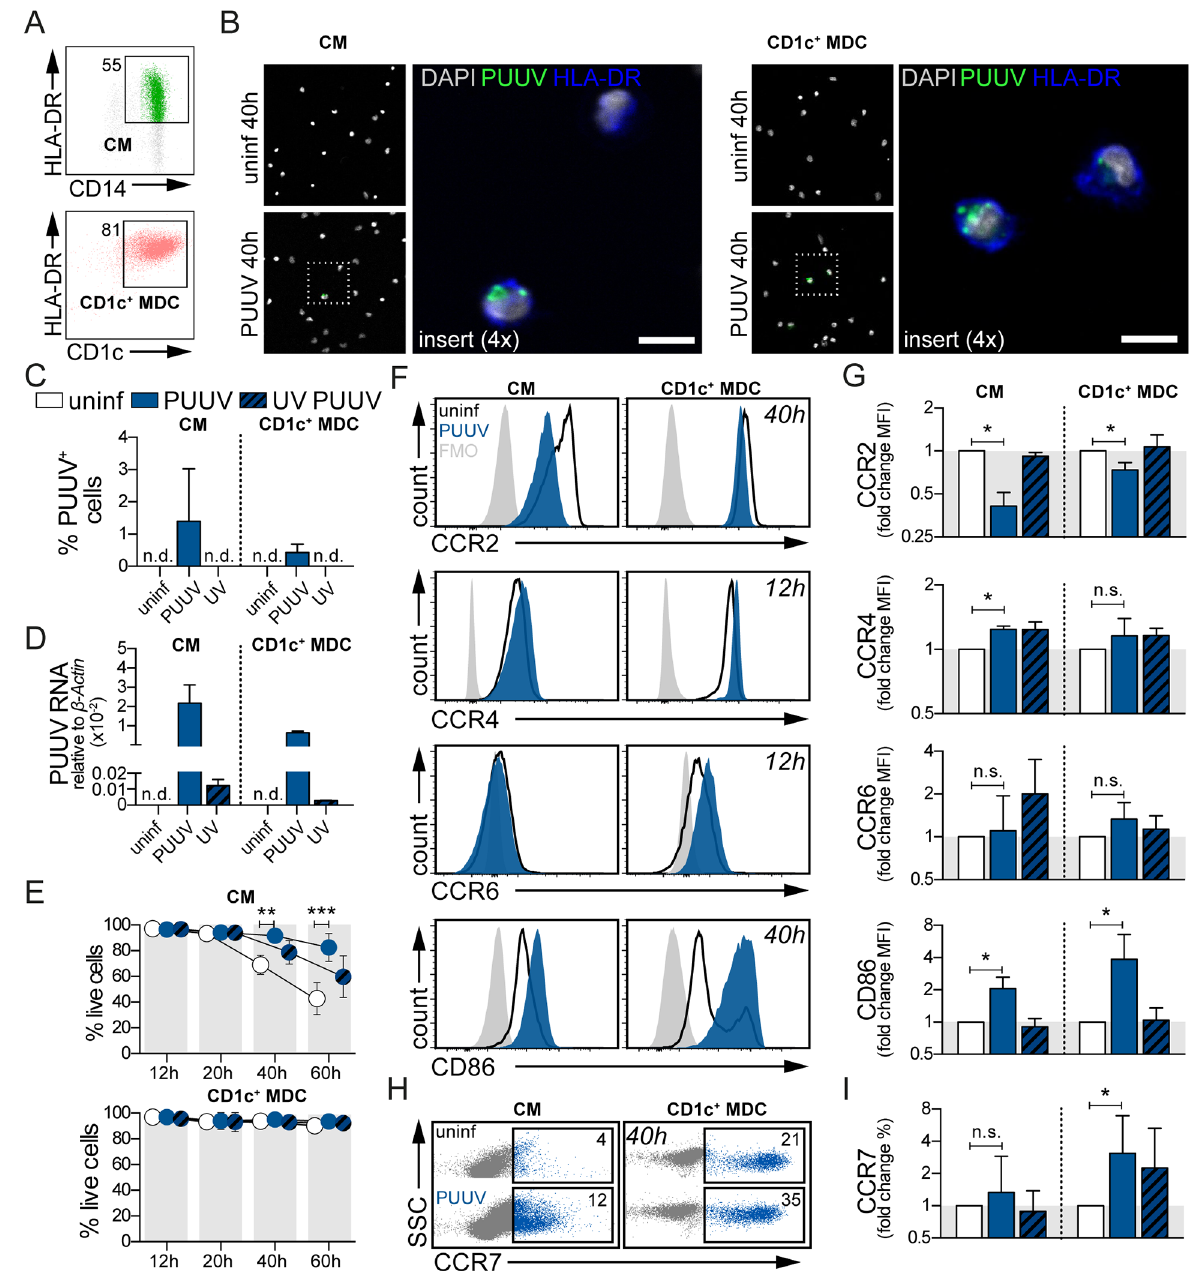
Fig 7. Susceptibility of classical monocytes and CD1c + MDCs to PUUV in vitro . ( A ) Human CM (top panel, green) and CD1c + MDCs (bottom panel, coral) were isolatedfrom peripheral blood of healthyvolunteers. Flow cytometry dot plots show live, HLA-DR + CD11c + CD14 + CD16 - monocytesor live, CD11c + CD1c + MDCs. Numbers in gate depict the frequency of cells out of total live cells. One representative donor of six is shown. Cells were left unexposed, exposedto PUUV or UV-inactivated PUUV for 2 h at an MOI of 7.5. Cells were washed and subsequently incubatedfor 12–60 h. ( B ) Immunofluorescence staining with patient serum on CM (left panel)and CD1c + MDCs (right panel)on uninfectedand PUUV-infected cells 40 h after infection indicatesdetectableviral antigen(green). Cells were counterstained with DAPI (gray) and also stainedfor HLA-DR (blue). Scale bar, 10 μ m. ( C ) Bar graphs summarize the mean ± SDof PUUV + CM (left panel, n = 3) or CD1c + MDCs (n = 3). n.d., not detectable. ( D ) Relative expressionof PUUV RNA was measuredin CM and CD1c + MDCs (n = 2) after 60 h of infection. Bar graphs show 2 - Δ Ct values relativeto the housekeeping gene β -Actin .( E ) Viability of cells was assessed by flow cytometry basedon a LIVE/DEAD dye. Graphs show mean ± SD viabilityof CM (top panel, n = 4) or CD1c + MDC (bottom panel,n = 6). ( F ) Histogramsindicate changesin expressionof CCR2, CCR4, CCR6 and CD86 in cells exposedto PUUV (ocean blue) comparedto unexposed(black line) from one representative donor of CM (n = 4) and CD1c + MDCs (n = 6). Fluorescence